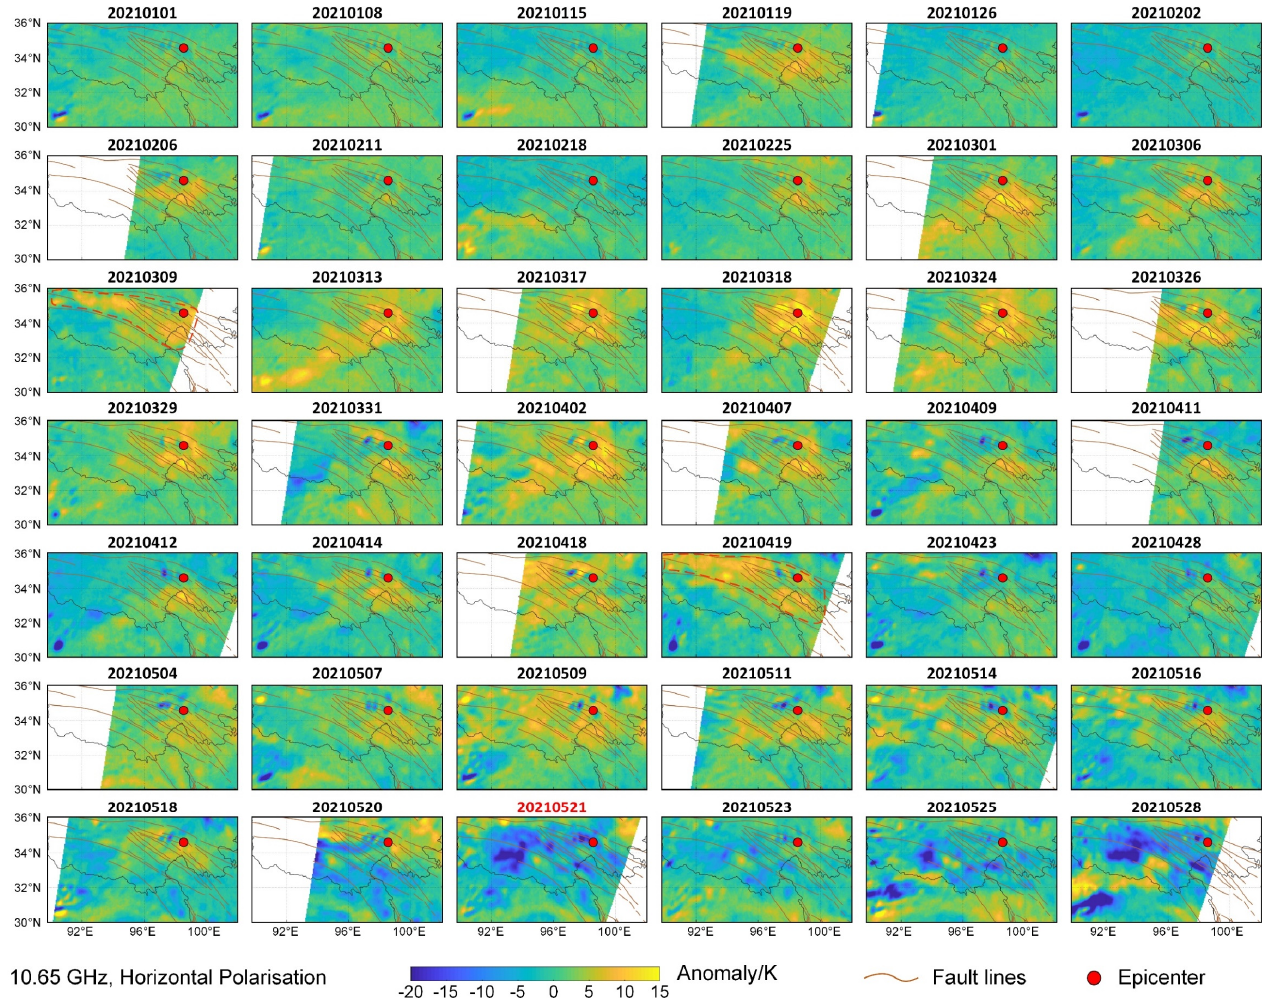
Figure 8. Spatio-temporal evolution of MBT anomalies with 10.65 GHz at H-pol related to the 2021 Maduo EQ.